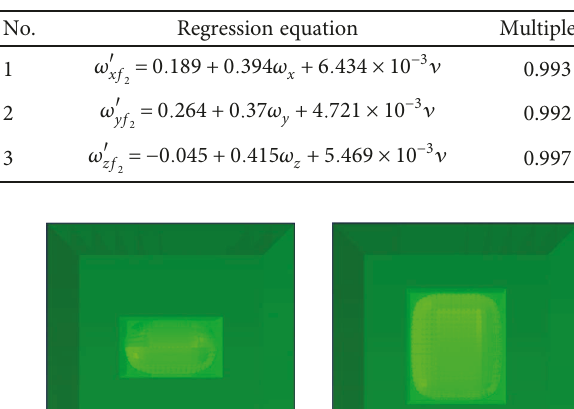
′ , ω ′ , and ω xf 2 yf 2